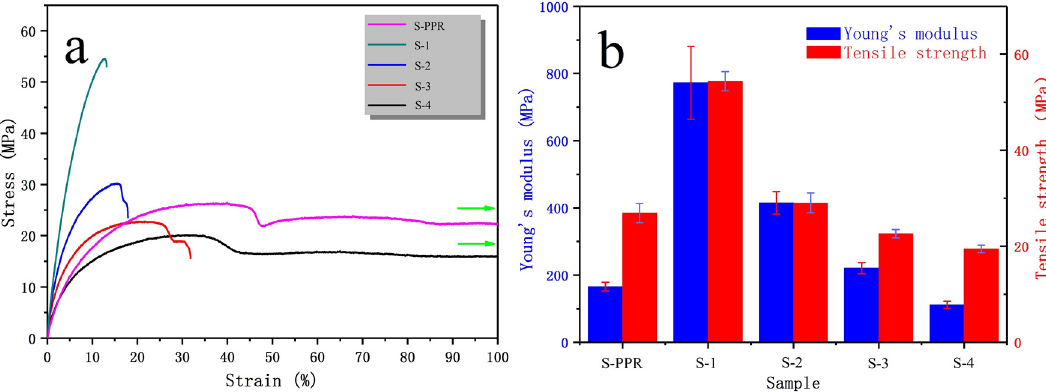
Figure 12. ( a ) Stress–strain curves of different filaments; ( b ) Young’s modulus and tensile strength of different filaments.